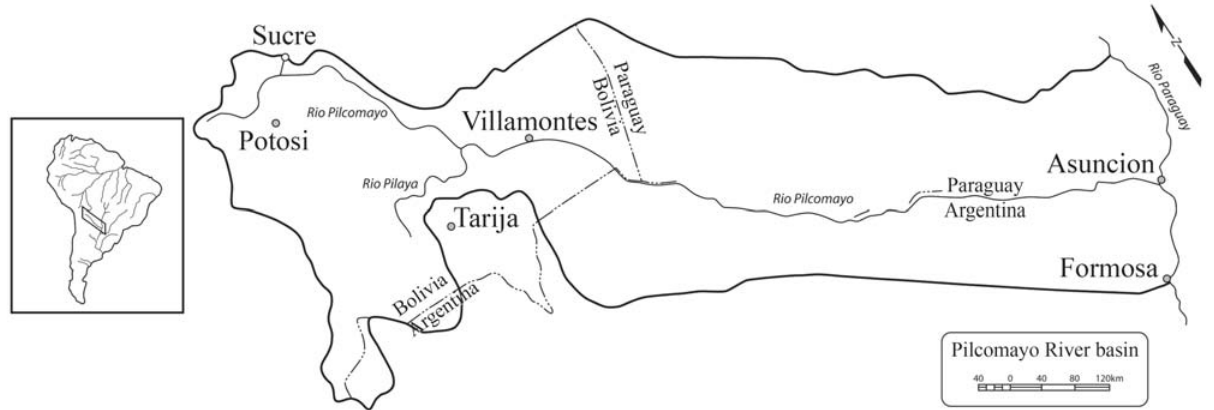
Fig. 1. Map of the Pilcomayo River basin.